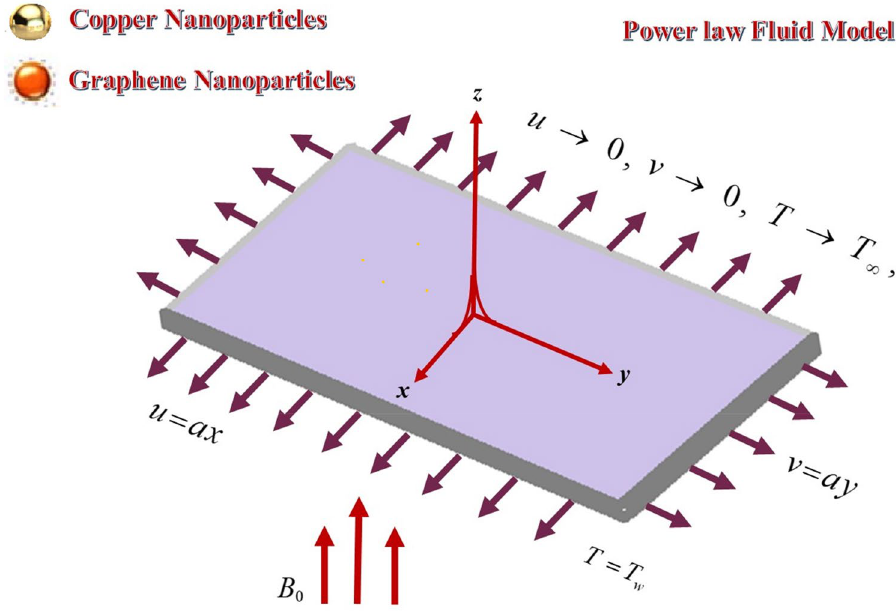
Figure 1. Hybrid nanofluid flow over a moving permeable